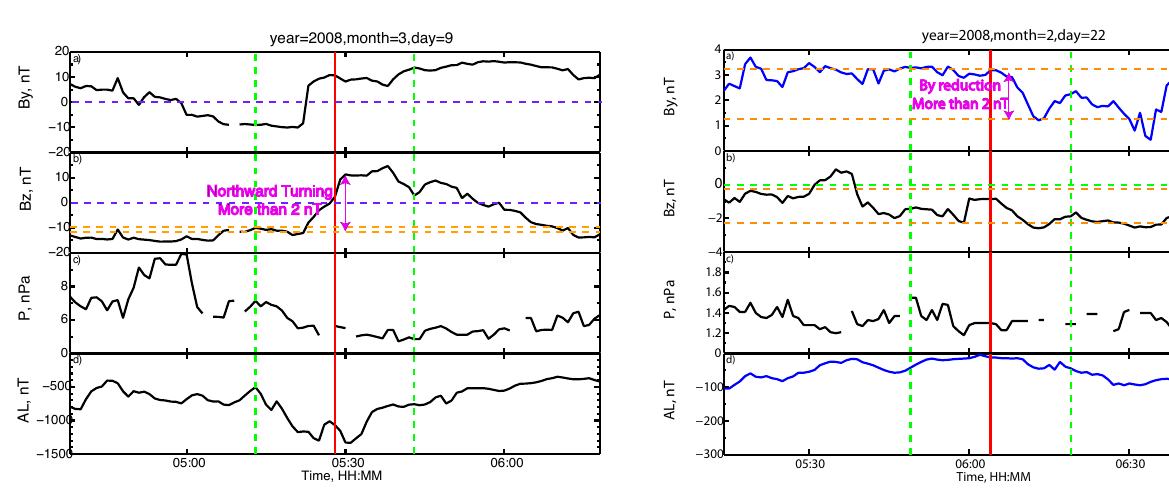
Fig. 2. Example of a B y -triggered event in the same format as Fig.